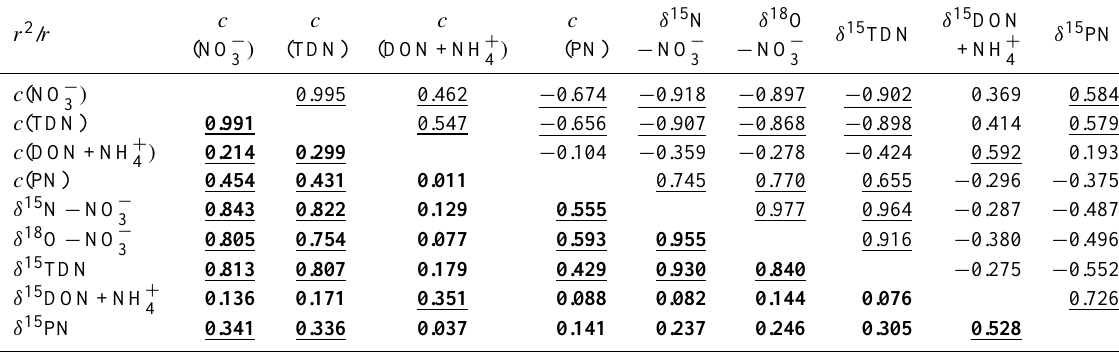
Table 1. Correlation coefficients of all measured parameters in the Elbe River at the weir of Geesthacht, June 2005–December 2007. r 2 in bold, underlined coefficients present a level of significance α ≤ 0.01.